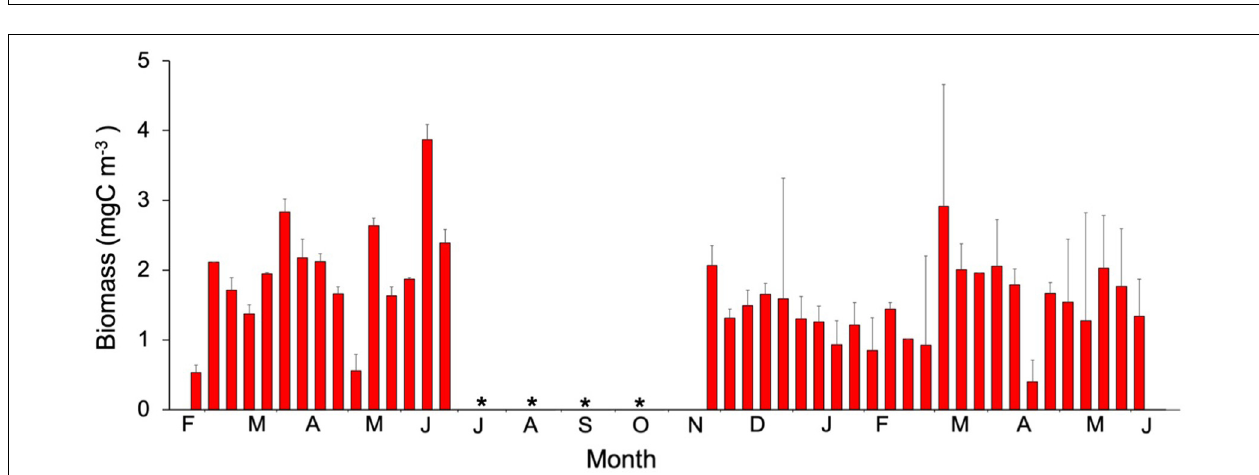
FIGURE 8 | Temporal variability of mesozooplankton biomass ( (cid:4) ). Values are the average of values (mean ± SE) for stations 1, 2, and 3. No data available is represented by an asterisk.